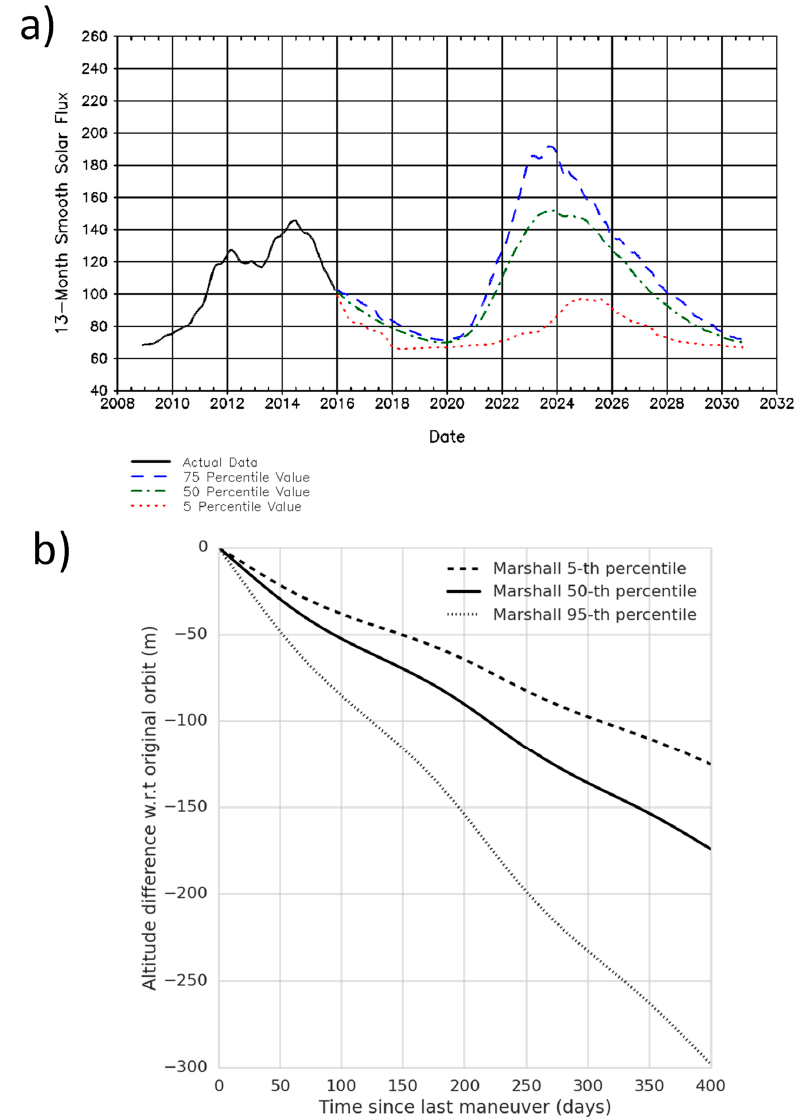
Figure 2. Panel ( a ) shows the solar flux prediction (unit: sfu, i.e., 10 − 22 W ⋅ m − 2 ⋅ Hz − 1 ) used as an input (from the National Aeronautics and Space Administration (NASA) Marshall Space Flight Center). Panel ( b ) shows the altitude decay with respect to the original ERS/ENVISAT orbit for three solar flux scenarios: 5-th percentile (weak solar activity), 50-th percentile (median solar activity) and 95-th percentile (very intense solar activity).